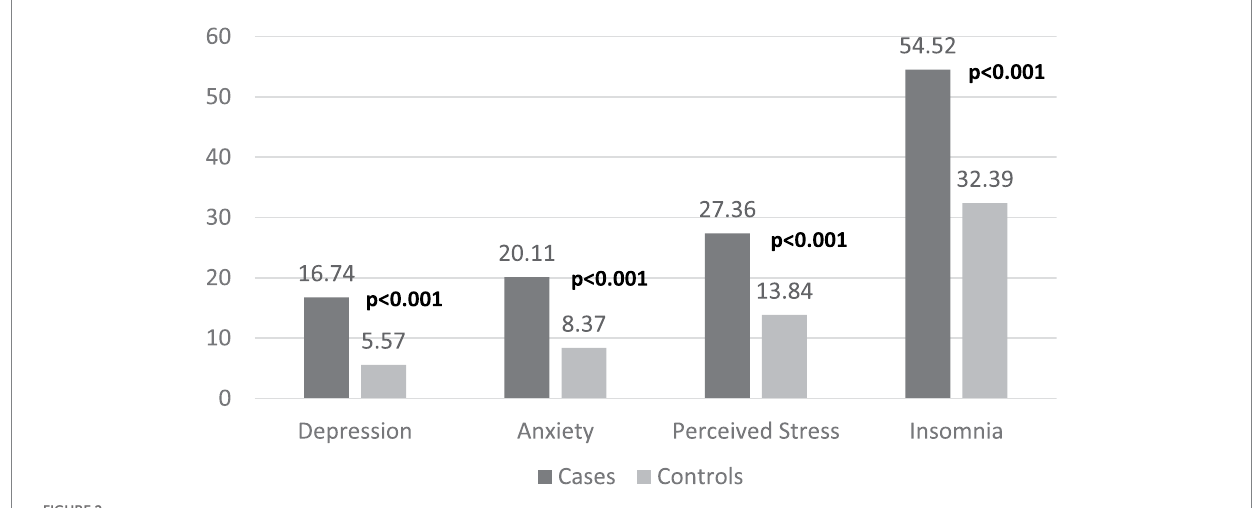
FIGURE 2 Comparison between cases and matched-controls in terms of mental health problems. Numbers in bold indicate significant value of p s.